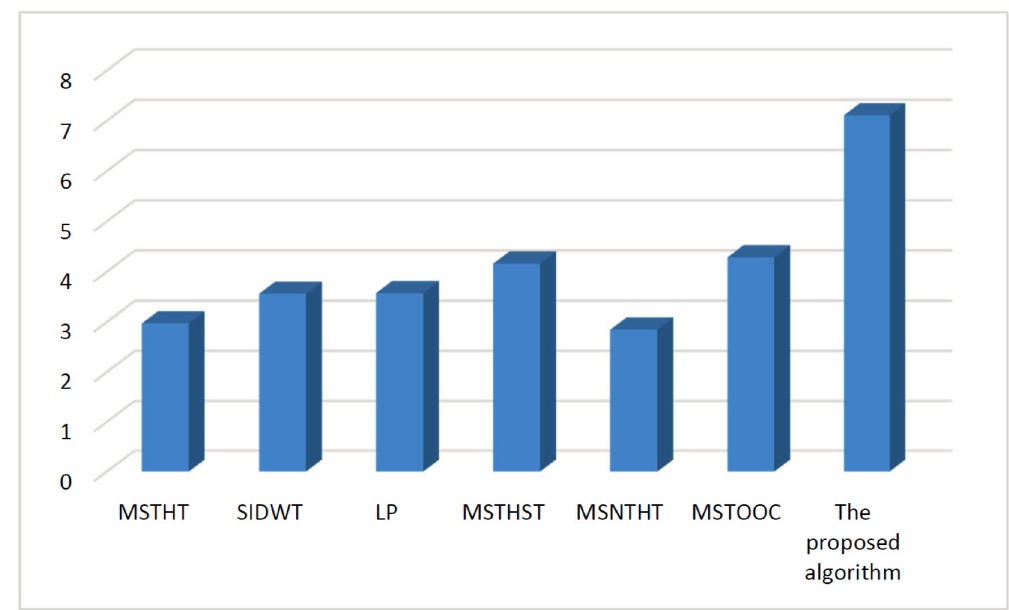
Figure 6. Quantitative comparison using measure mean gradient.